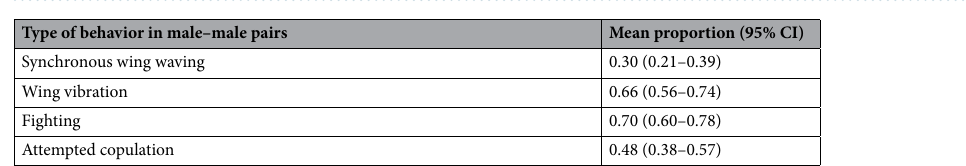
Figure 3. Percentages (mean and 95% CI) of wing vibrating males ( a ) and boxplots of duration of wing vibration ( b ) in different social situations.